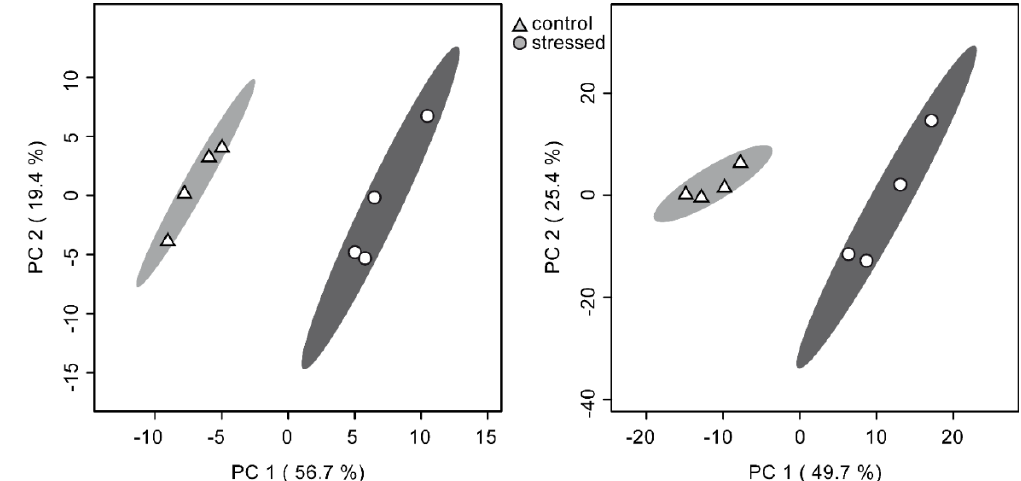
Figure 4. Principal component analysis (PCA) of the comparative metabolomics experiment with samples split and measured on both the unit-mass ISQ GC–MS (left) and the high-resolution Orbitrap GC–MS (right). Data shown was log transformed and autoscaled. There is no discernible difference between both low- and high-resolution systems concerning the ability to separate samples into experimental groups in this study.